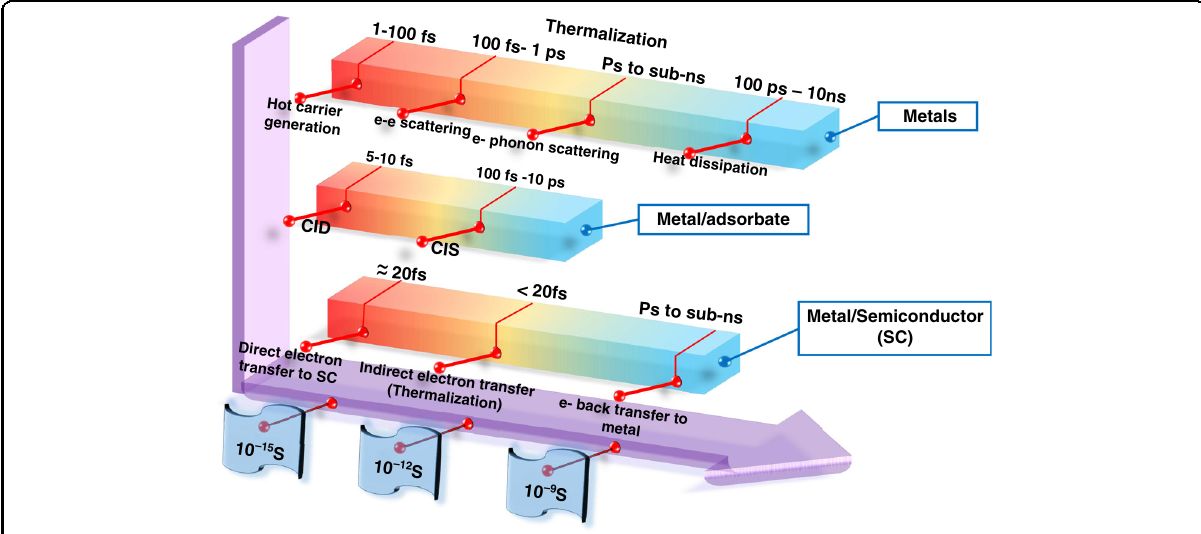
Fig. 17 The timescale of the plasmon-induced HC generation, their transfer, and thermalization processes in the presence of an adsorbate of semiconductor. Note that SC stands for semiconductor, e stands for electron and CID & CIS refer to the chemical interface damping and the chemical interface scattering, respectively. The idea of the fi gure has been taken from ref. 102 , modi fi ed and redrawn